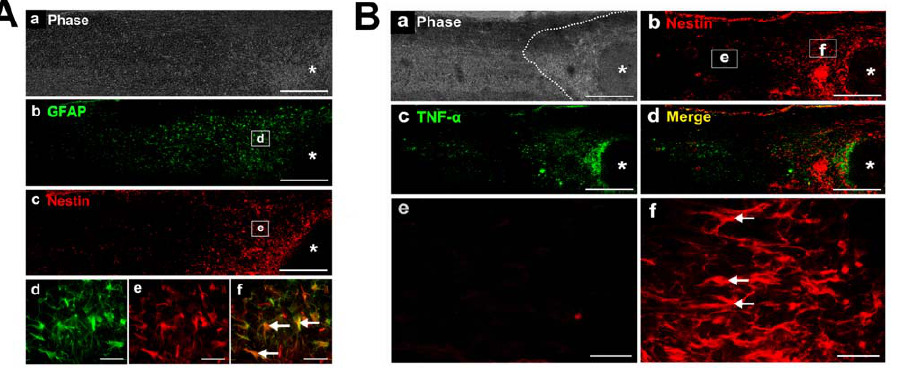
Figure 6. Astrocytes are activated to secrete TNF- a in hemisection SCI model. (A)Ten days after SCI, immunohistochemical analysis was performed for the reactive astrocytes with anti-GFAP and anti-nestin. (d, e) Higher magnification of the outlined areas in b and c showed reactive astrocyte with an extensive hypertrophy of their cell bodies and cytoplasmic processes. (f) A merged picture of d and e. Scale bars: 500 m m (a–c); 50 m m (d–f). (B) TNF- a produced by reactive astrocytes was examined by double-stained with antibodies against nestin and TNF- a 10 days after SCI (a–d). (e, f) Higher magnification of the outlined areas in b. Scale bars: 500 m m (a–d); 50 m m (e, f). Asterisk indicates the lesion site. Dashed line in B indicates approximate border of the glial scar. Arrows indicate representative reactive astrocytes.